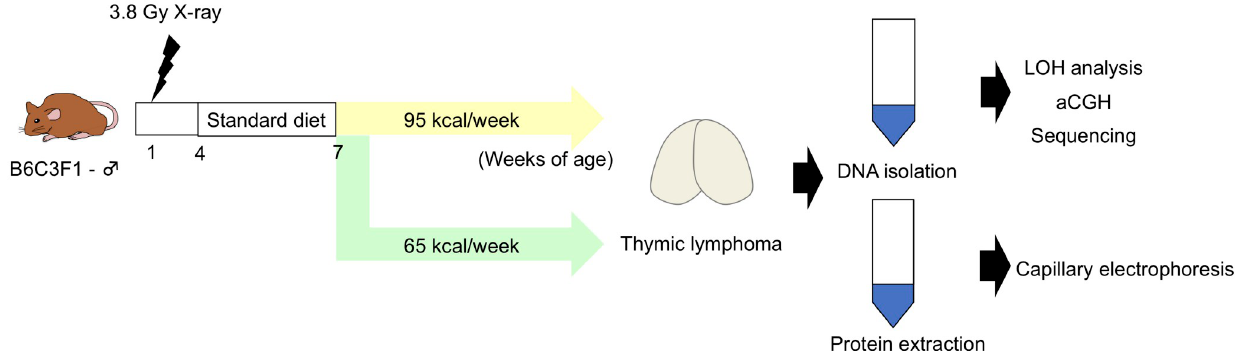
Fig 1. Experimental design. Male mice were irradiated with 3.8 Gy of X-rays at 1 week of age, weaned at 4 weeks of age, and fed a standard diet until 7 weeks of age. After 7 weeks of age, the mice were fed a 95 kcal/week or 65 kcal/week (calorie-restricted) diet. DNA copy number, loss of heterozygosity (LOH), point mutations, and protein expression of tumor suppressor genes in radiation-induced TLs were analyzed.